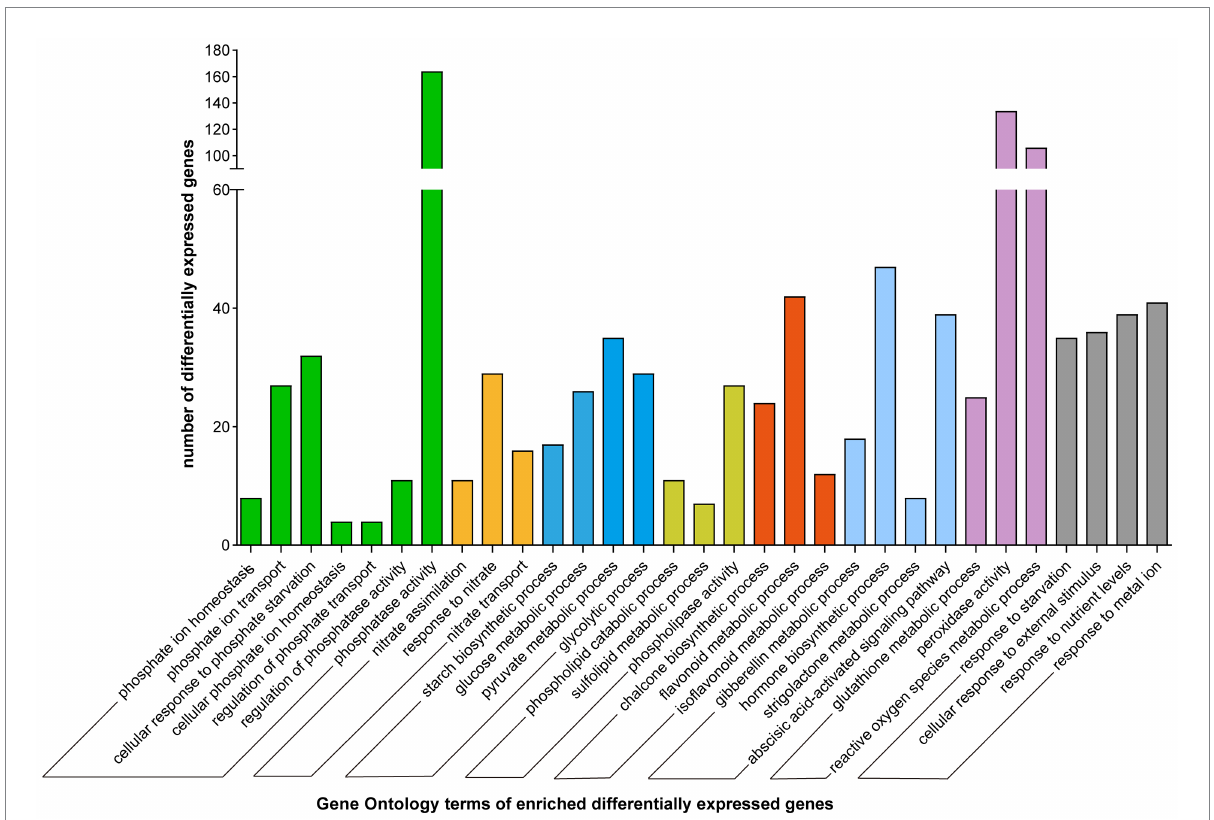
FIGURE 2 Gene ontology enrichment of differentially expressed genes. Different color represents different functional